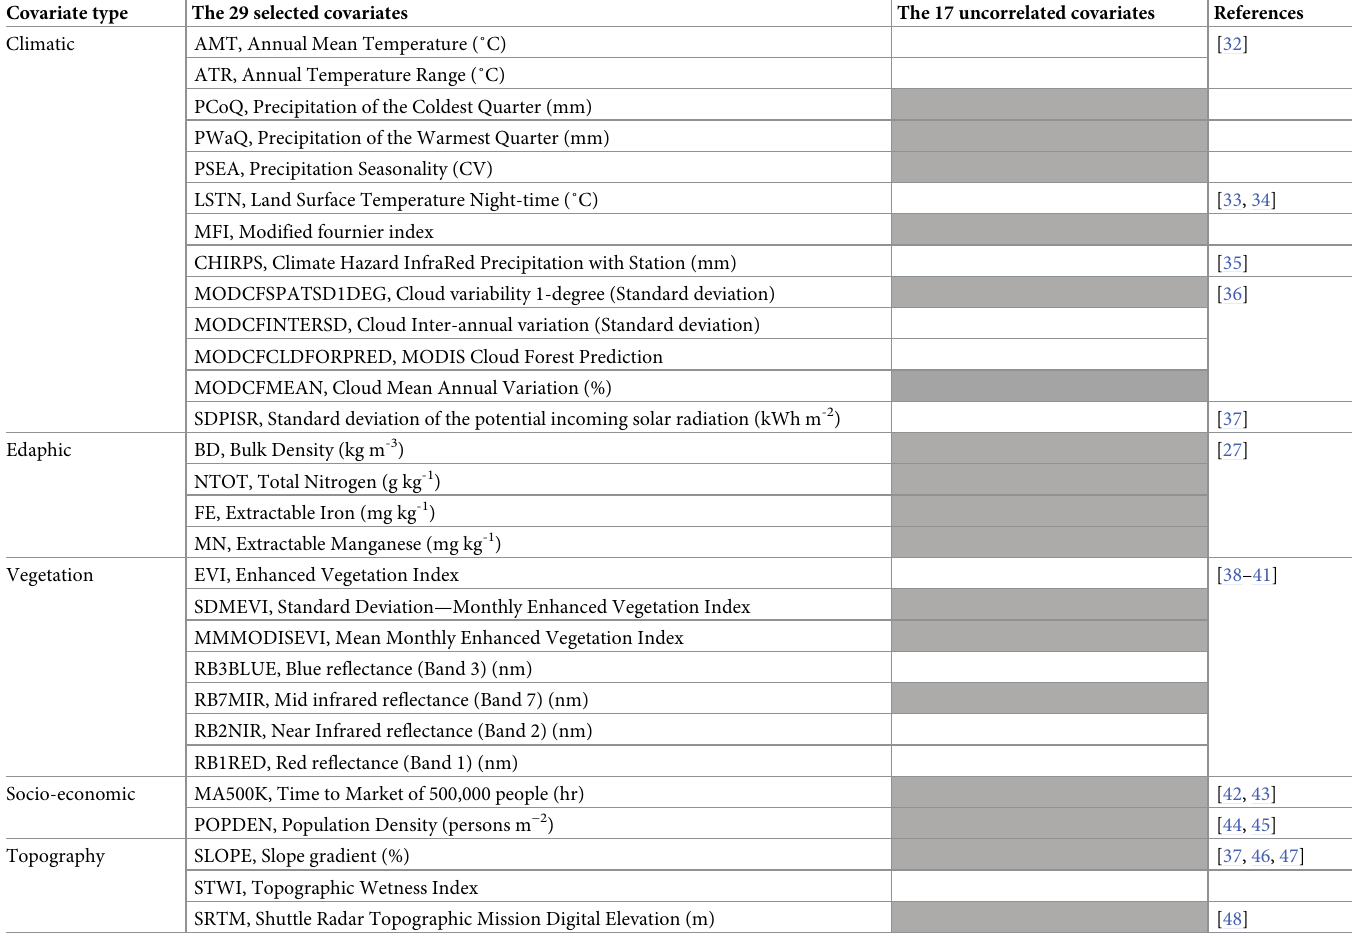
Table 1. List of 29 covariates selected from a list of 71 variables using recursive feature elimination and further selection of 17 uncorrelated covariates (shaded grey). Covariate